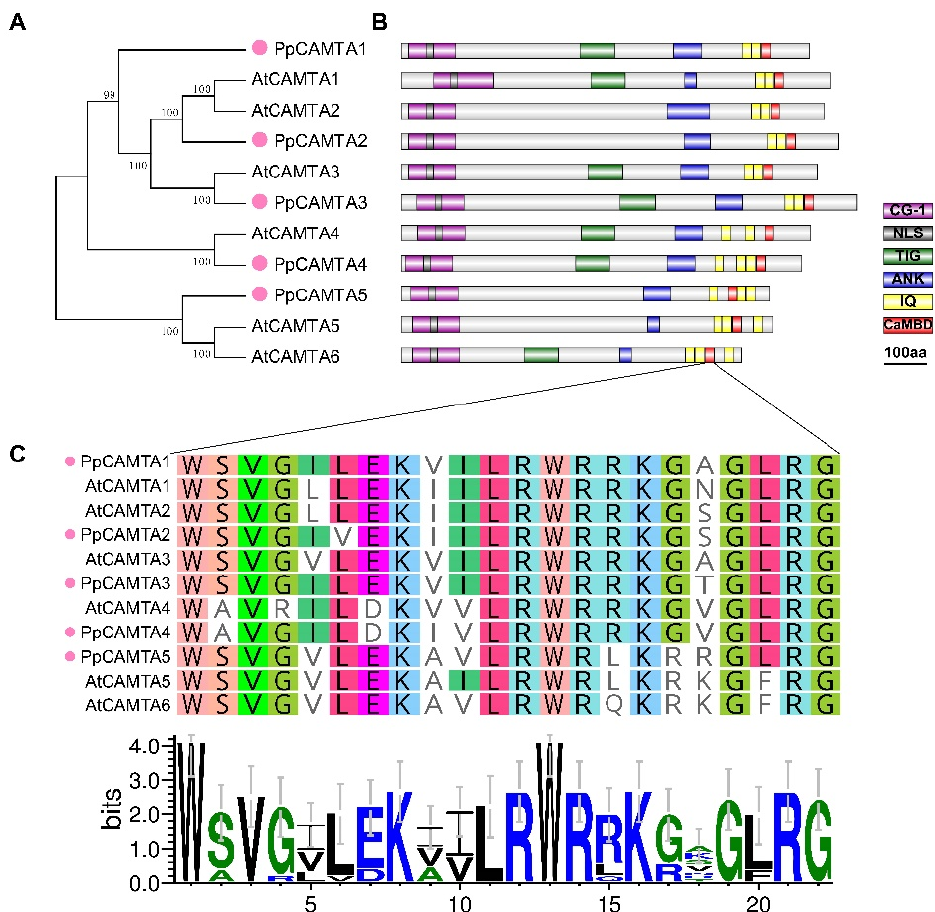
Figure 1. Phylogenetic relationship and conserved protein domains between peach and Arabidopsis CAMTAs. ( A ) Phylogenetic analysis of the peach and Arabidopsis CAMTAs. Peach CAMTAs were marked with pink dots. ( B ) Protein conserved domain composition in peach and Arabidopsis CAMTAs. Different protein domains were indicated in different colors. ( C ) Alignment of the CaMBD sequence between peach and Arabidopsis CAMTAs. The sequence logo of the functional residues in CaMBD domain of these CAMTAs was displayed below.